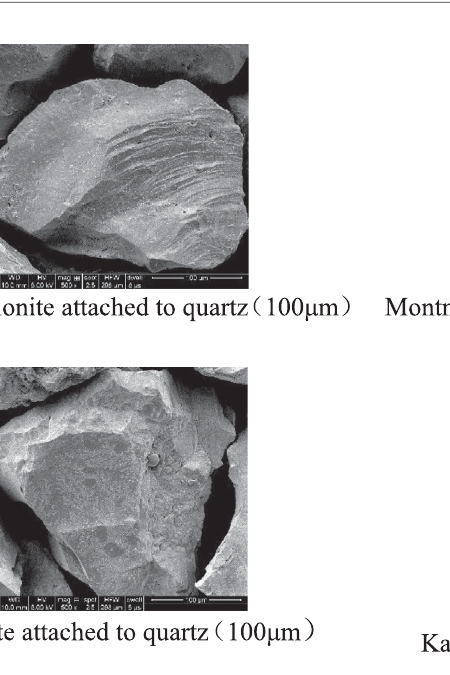
FIGURE 2 | Scanning electron micrograph (SEM) of (A) montmorillonite and (B) kaolinite attached to quartz.